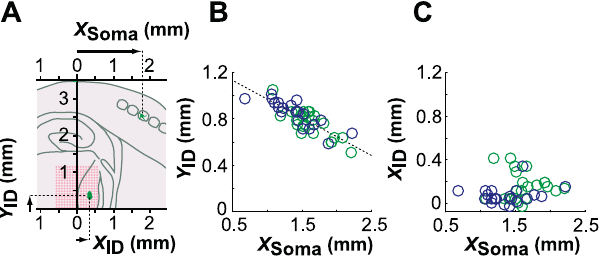
Figure 5. Thalamocortical Topographic Transformations (A) Schematic of the coordinate system. X ID and Y ID are the horizontal and vertical coordinates of the input domain, respectively. X Soma is the horizontal coordinate of the cell position in cortex. X ID and X Soma are measured from the VPM/POm boundary (center of the uncaging grid; light red). Y ID is measured from the bottom of VPM (bottom of the uncaging grid). (B) and (C) Positions of the input domains ( Y ID in B ; X ID in C) in VPM (green) and POm (blue) as a function of X Soma . Cells were in L4 ( n ¼ 12); L5B ( n ¼ 7); L6A ( n ¼ 5); and L5A ( n ¼ 21). Dashed line shows the linear correlation between X Soma and Y ID for VPM and POm domains ( r 2 ¼ 0.72).